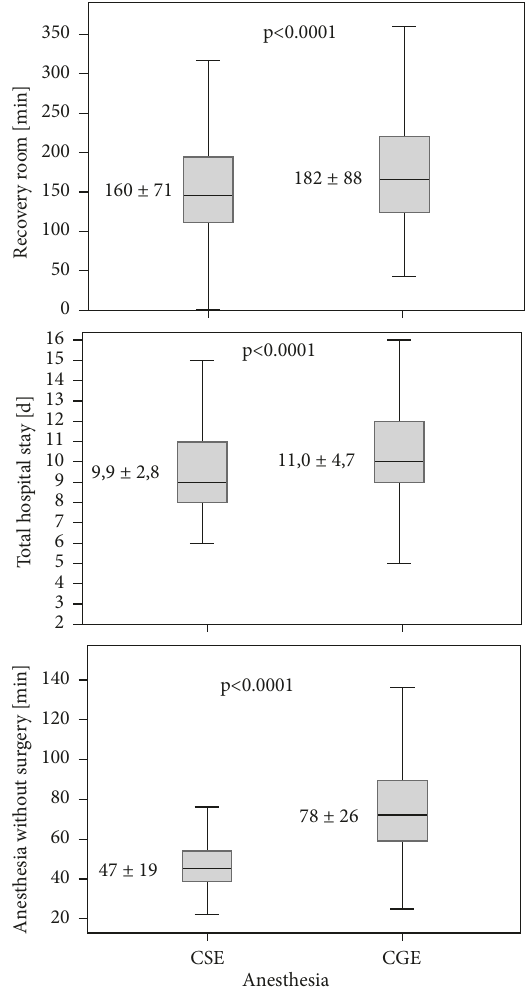
Figure 2: Total anesthesia without surgery, time in the post- anesthesia care unit and total hospital